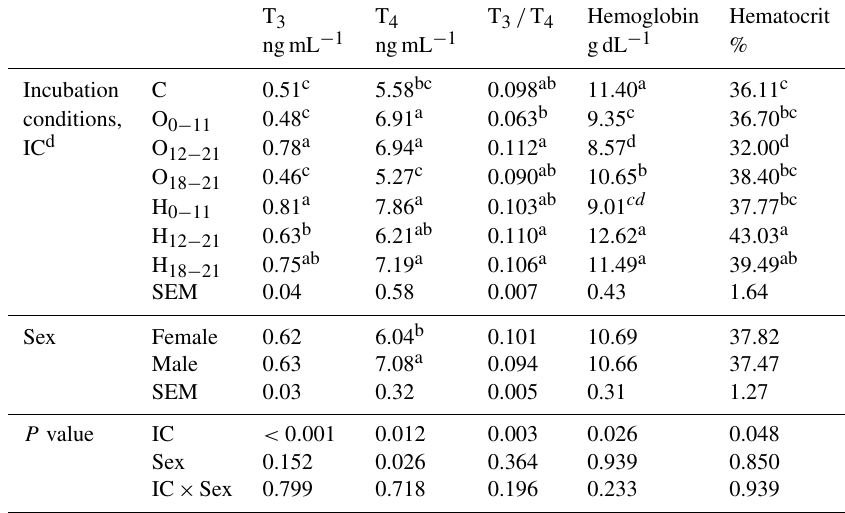
Table 6. Effects of incubation conditions and sex on blood parameters induced by hypoxia at high altitude for newly hatched chicks. T 3 T